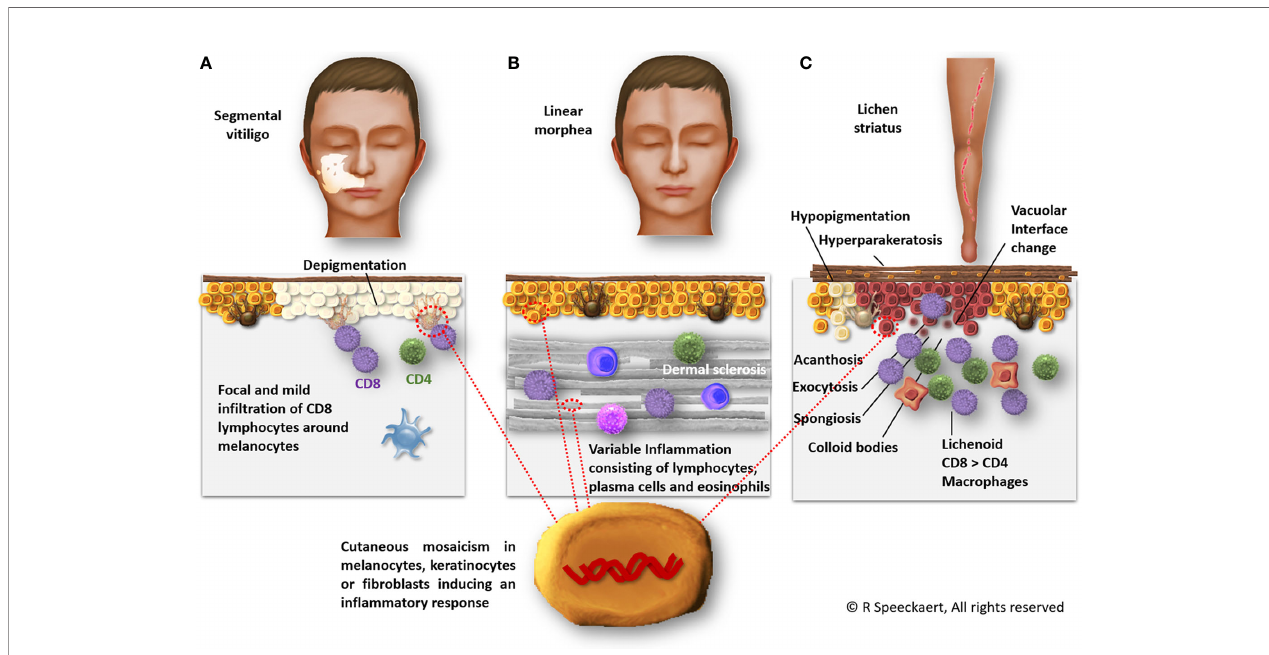
FIGURE 1 | Segmental vitiligo, linear morphea, and lichen striatus are presumed to share a similar pathogenesis based on a genetic mosaicism causing an in fl ammatory response. In segmental vitiligo (A) , a CD8-dominant in fi ltrate around melanocytes is observed ultimately leading to melanocyte destruction. Linear morphea (B) is characterized by dermal sclerosis and an in fl ammation of variable extent consisting of lymphocytes, plasma cells, and occasional eosinophils. Lichen striatus (C) exhibits a focal lichenoid lymphocytic in fi ltrate with macrophages. Hyperparakeratosis, acanthosis, exocytosis, spongiosis, vacuolar interface dermatitis, and colloid bodies can be